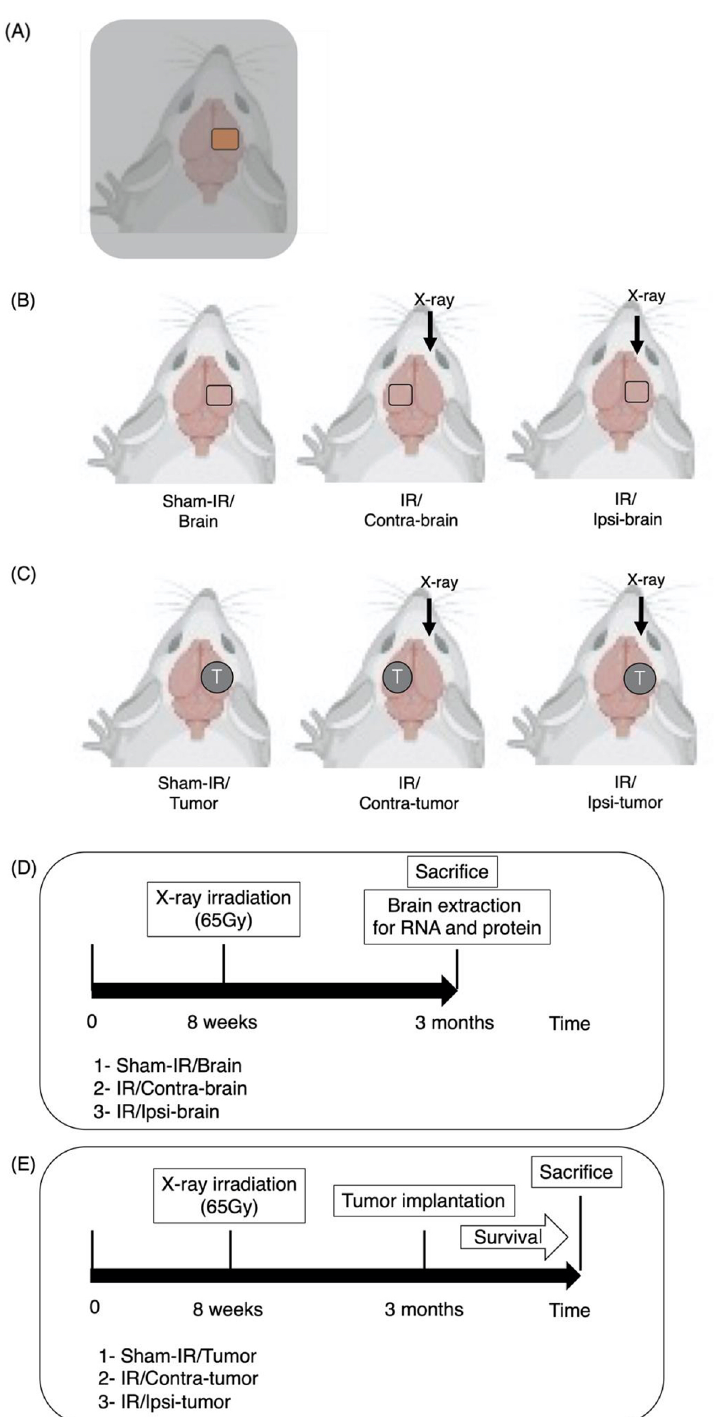
Figure 7. ( A ) Schema of X-ray irradiation to the rat brain (created with BioRender.com). The whole body of rat was covered with a lead plate with a 1 cm square window, and only a part of the right cerebral hemisphere was irradiated with X-rays. ( B ) Treatment schema of the three groups of male Fisher rats for in vitro study (created with BioRender.com). X-ray: X-ray irradiation. IR/Ipsi-brain group: X-ray was irradiated only a part of the right cerebral hemisphere and the tissue of the right hemisphere was used. IR/Contra-brain group: X-ray was irradiated only a part of the right cerebral hemisphere and the tissue of the left hemisphere was used. Sham-IR/Brain group: no irradiation was performed and the tissue of the right hemisphere was used. ( C ) Treatment schema of the three groups of Fisher rats implanted tumor for in vivo study (created with BioRender.com). T: implanted tumor. IR/Ipsi-tumor group: F98 cells were transplanted to the right hemisphere after irradiation to the right hemisphere. IR/Contra-tumor group: F98 cells were transplanted to the left hemisphere after irradiation to the right hemisphere. Sham-IR/Tumor group: F98 cells were transplanted to the right hemisphere without irradiation. ( D ) Timeline describing the timing of irradiation, sacrifice and brain extraction in vitro assay. Three months after the X-ray irradiation, we extracted the tissue protein and RNA from rat brain. ( E ) Timeline describing the timing of irradiation, tumor implantation and sacrifice for in vivo assay. Three months after the irradiation, F98 glioma cells were implanted into the cerebral hemisphere of